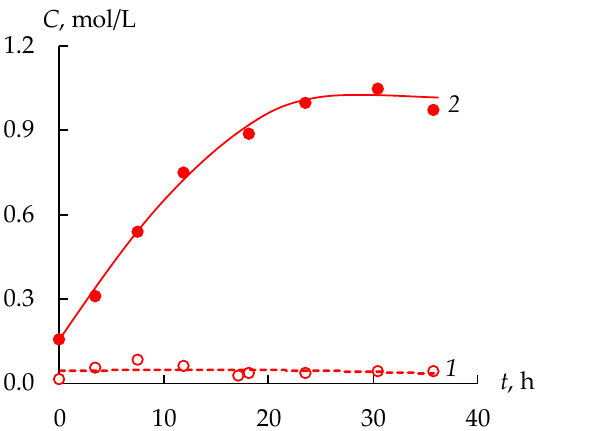
Figure 5. The sulfuric acid concentrations in the intermediate (1) and concentrate (2) tanks during the operation of the installation.